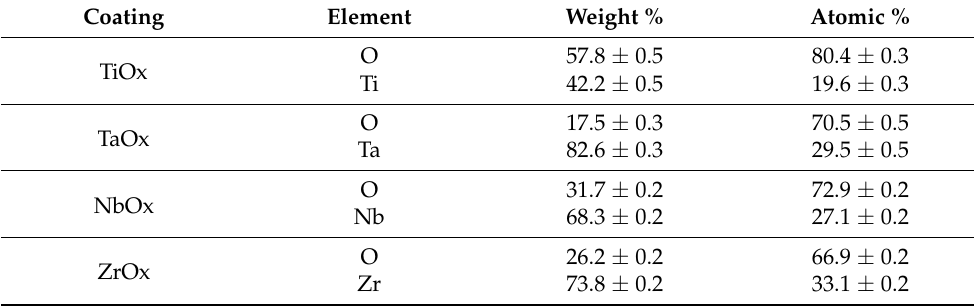
Table 1. Coatings elemental composition as obtained from EDS analysis.